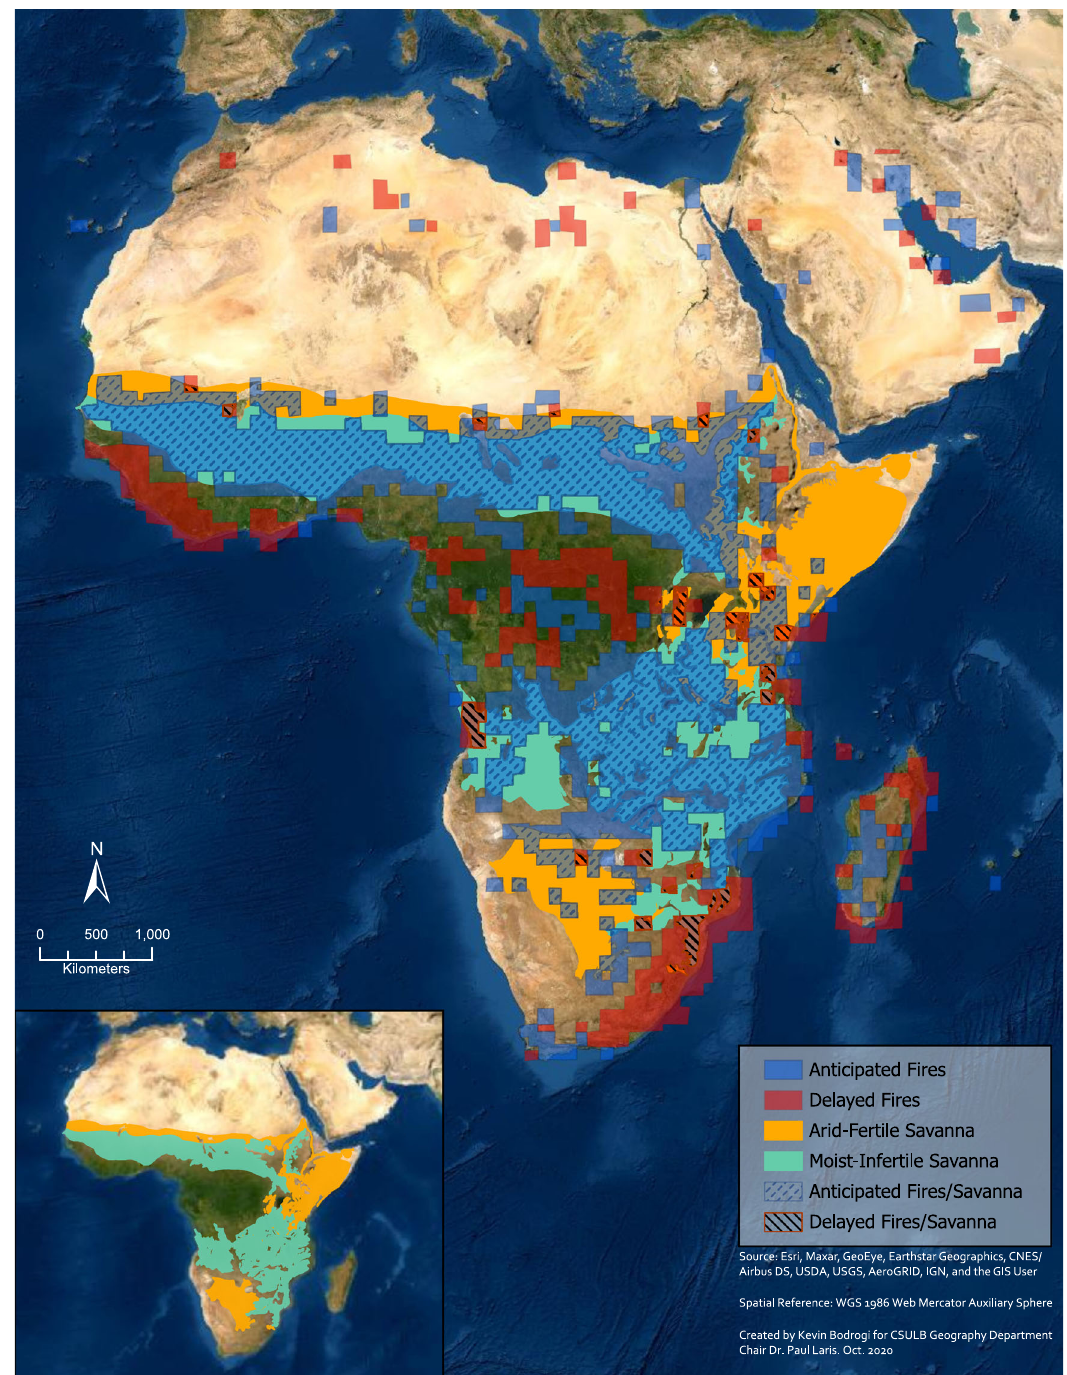
Fig. 2 Map of early (anticipated) and late (delayed) fi re seasons for Africa modi fi ed from Le page et al. 7 over White ’ s savanna vegetation map 25 . Using threshold at ±30 days of difference between the values per grid cell for the middle of the fi re season and middle of the CBI season, less than 6% of African savannas burn late. (Sources: Source: Esri, Maxar, GeoEye, Earthstar Geographics, CNES/ Airbus DS, USDA, USGS, AeroGRID, IGN, and the GIS User Community. Created by Kevin